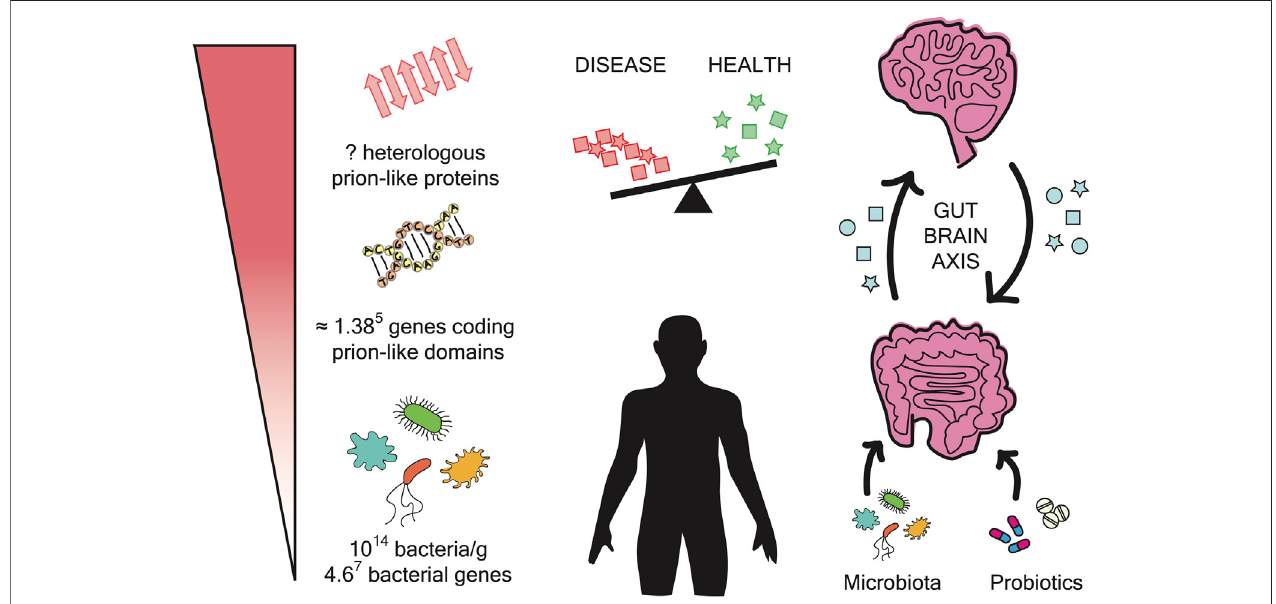
FIGURE1| Microbiomeimpactonamyloidogenesis.Thegutmicrobiomeiscomposedofapproximately10 14 bacteriaandcontains4.6 7 bacterialgenes.Theprion prediction tools have measured approximately 0.3% prions per genome. In the microbiome, this can result in approximately 1.38 5 genes coding for prion-like domains. The expression ofthesegenescanproducealargenumber ofpolypeptidesequences withthepotentialtoform amyloid fi brils. Theseaggregates may havethe abilityto interfere with and cross-seed human proteins. The gut and the brain are interconnected by a bidirectional axis. In addition, it has been reported that changes in microbiota composition are related to neurodegenerative diseases. Overall, the administration of probiotics could be a potential therapeutic strategy to treat these disorders.